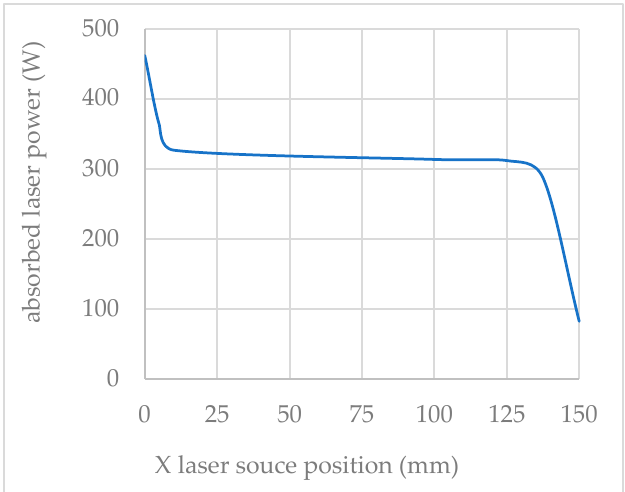
Figure 4. Absorbed laser power profile, (T510V5).